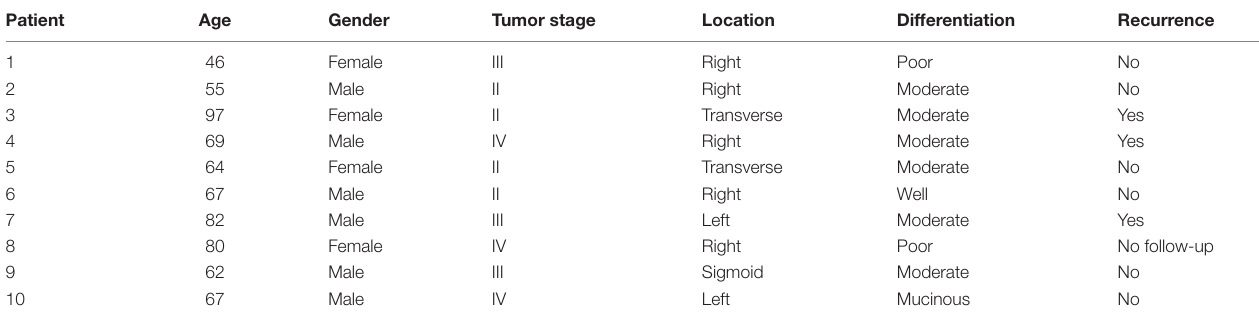
TaBle 1 | characteristics of the tumor samples (and their paired resection margins) used in this study.